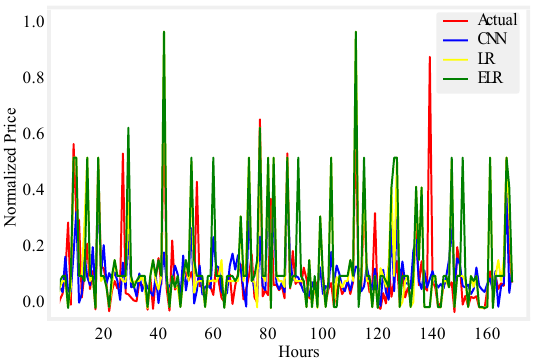
Figure 9. One week price prediction using UMass.